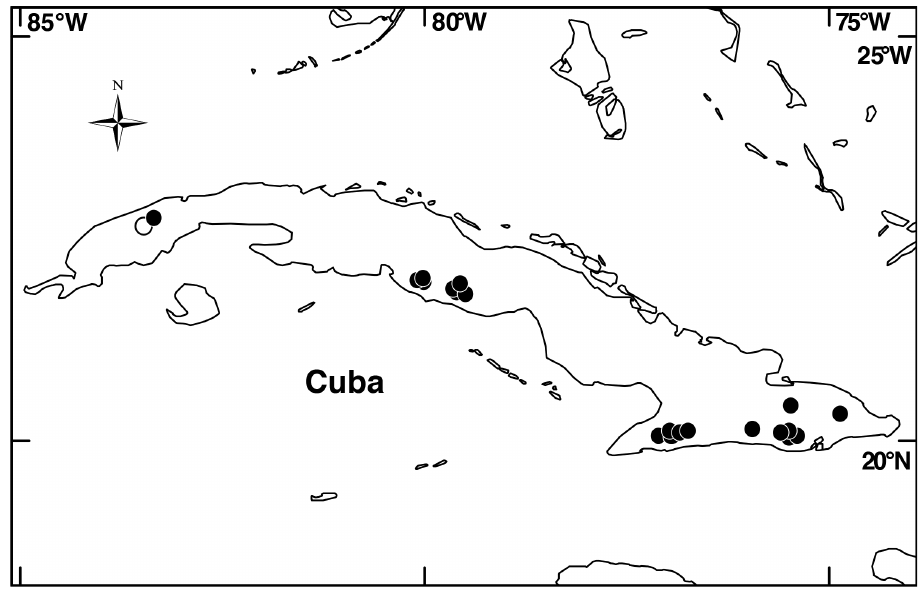
Figure 13. Distribution of Miconia cubana (open circle) and M. ottoschmidtii (close